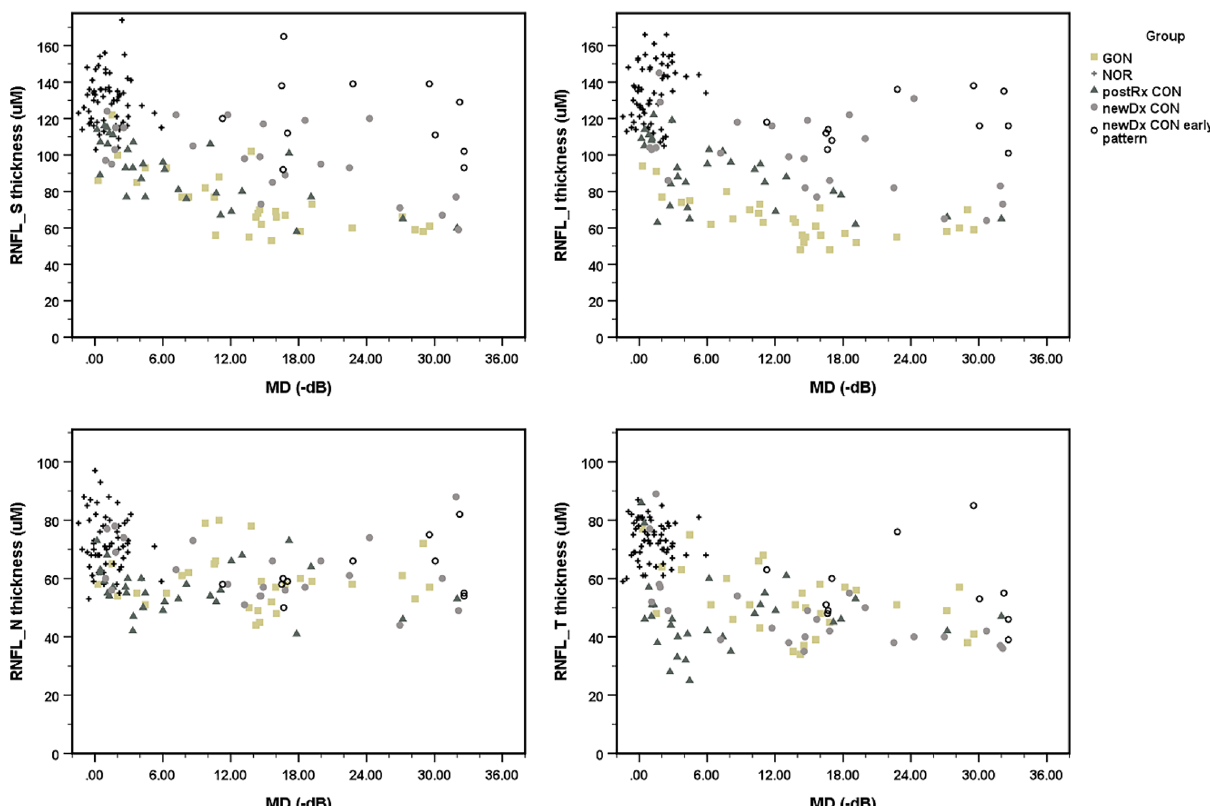
Figure 1. The scatter plot illustrates the distribution of cross-sectional data between peripapillary OCT parameters from individual cases versus the corresponding MD index of visual losses of each diagnostic group and control. GON glaucomatous optic neuropathy, CON compressive optic neuropathy, NOR healthy control, postRx post-treatment, newDx newly diagnosed, newDx CON Early pattern 11 of 34 newly diagnosed CON eyes show apparent disproportionally milder degree and or earlier pattern of structural thinning compared to the associated visual field losses, RNFL peripapillary retinal nerve fiber layer parameter, S superior quadrant, I inferior quadrant, N nasal quadrant, T temporal quadrant, uM micrometer, MD mean deviation, dB